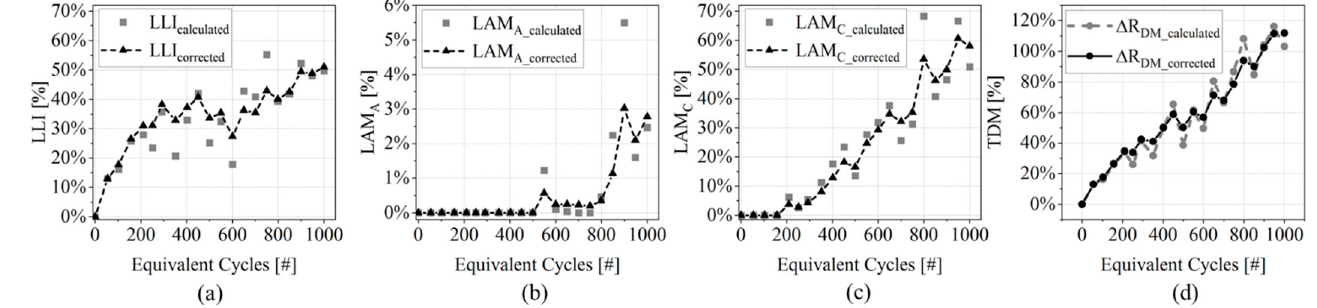
Figure 7. Example of degradation indicators computed for cell ID:REF (cycling in reference condition, C/3 symmetric with Constant Voltage-phase during charge). The plots show both the not corrected and corrected values of: ( a ) 𝐿𝐿𝐼 , ( b ) 𝐿𝐴𝑀 𝐴 , ( c ) 𝐿𝐴𝑀 𝐶 and ( d ) 𝑇𝐷𝑀 .